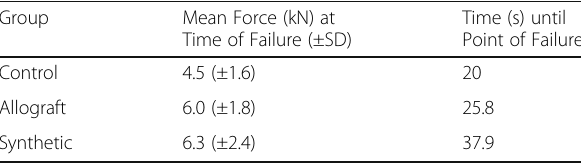
Table 1 Mean force/standard deviation (kN) and time (s)